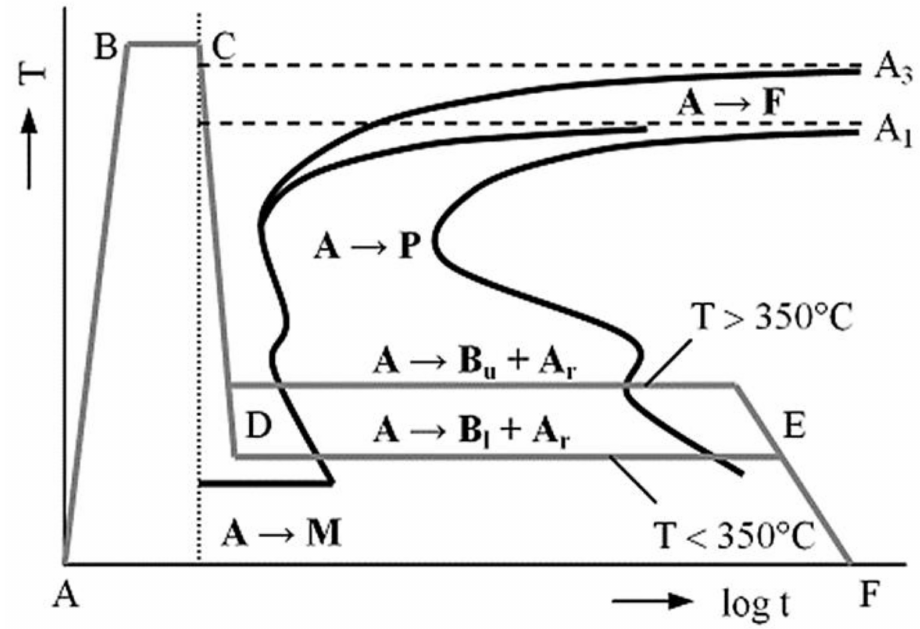
Figure 5. Isothermal heat treatment of the designated heat treatment sections (A—austenite, F—ferrite, P—pearlite, B u —upper bainite, B l —lower bainite, A r —retained austenite, M—martensite)